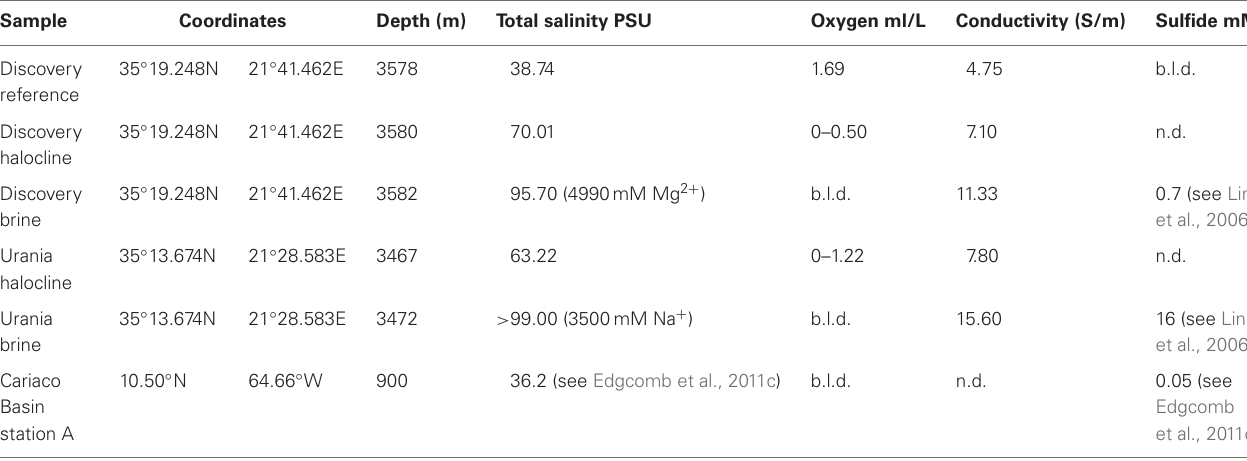
Table 1 | Physicochemical data for sampling sites at Discovery, Urania, and Caricao